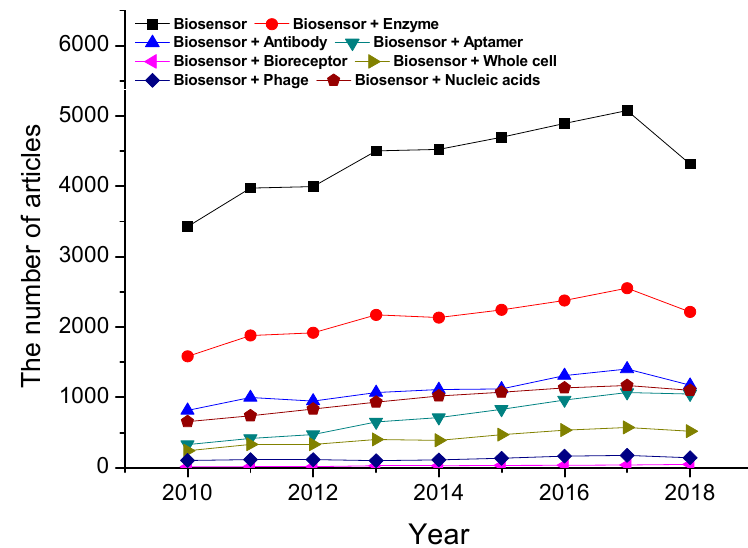
Figure 1. Trends in the annual numbers of published articles regarding bioreceptor-based biosensors (2010–2018). The horizontal axis represents the publication year, and the vertical axis shows the annual numbers of articles on scientific research.